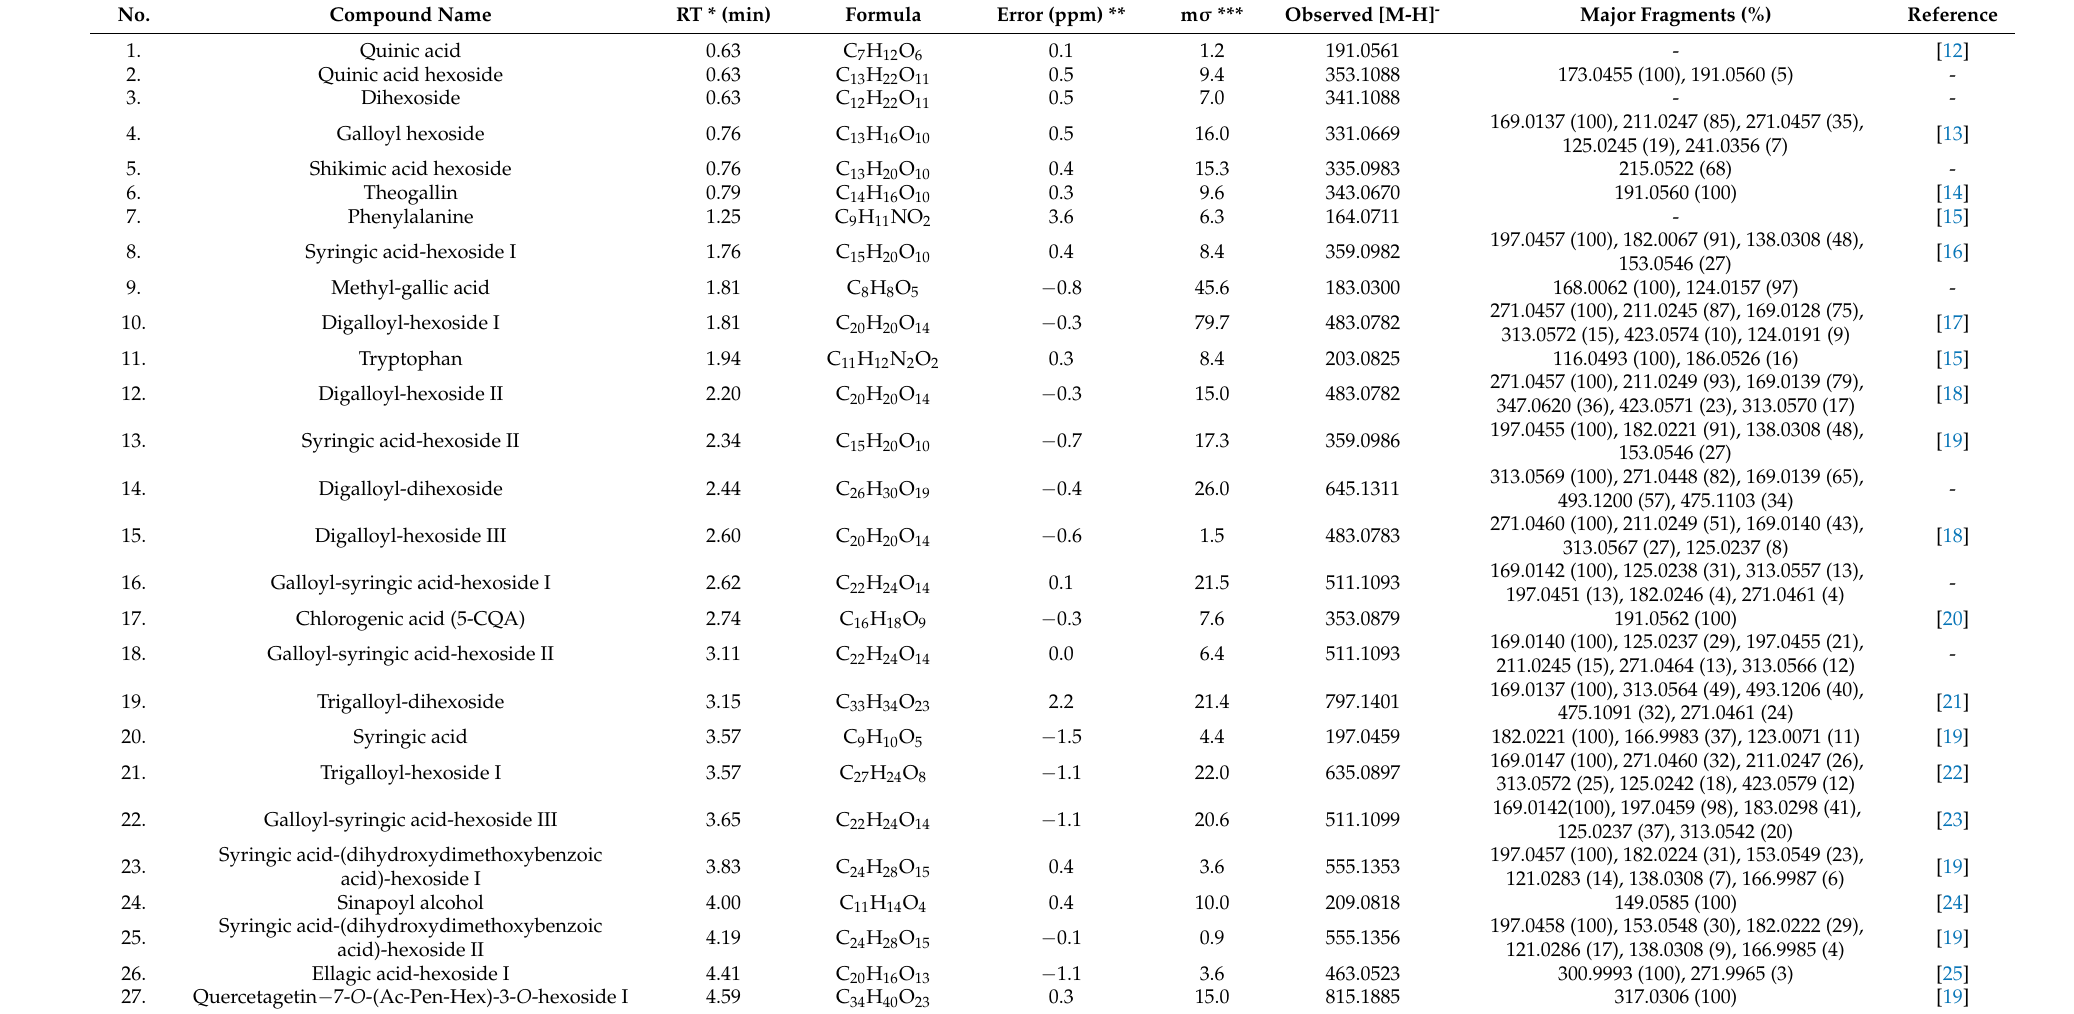
Table 1. Compounds identified in the T. erecta L. total methanolic extract using